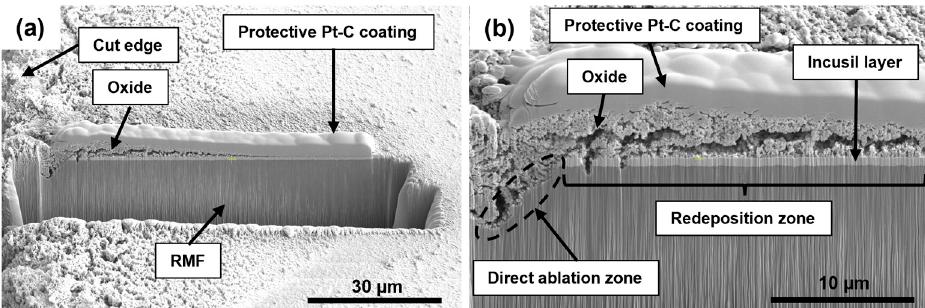
Figure 3. FIB cross section of the debris zone of RMF structured at 100 fs at 1 kHz. ( a ) Overview of the cross section; ( b ) detail of the left end at the cut edge. The presence of the undamaged InCuSil layer indicates that direct ablation did not take place. The debris has a low density and a maximum thickness of 4.85 µ